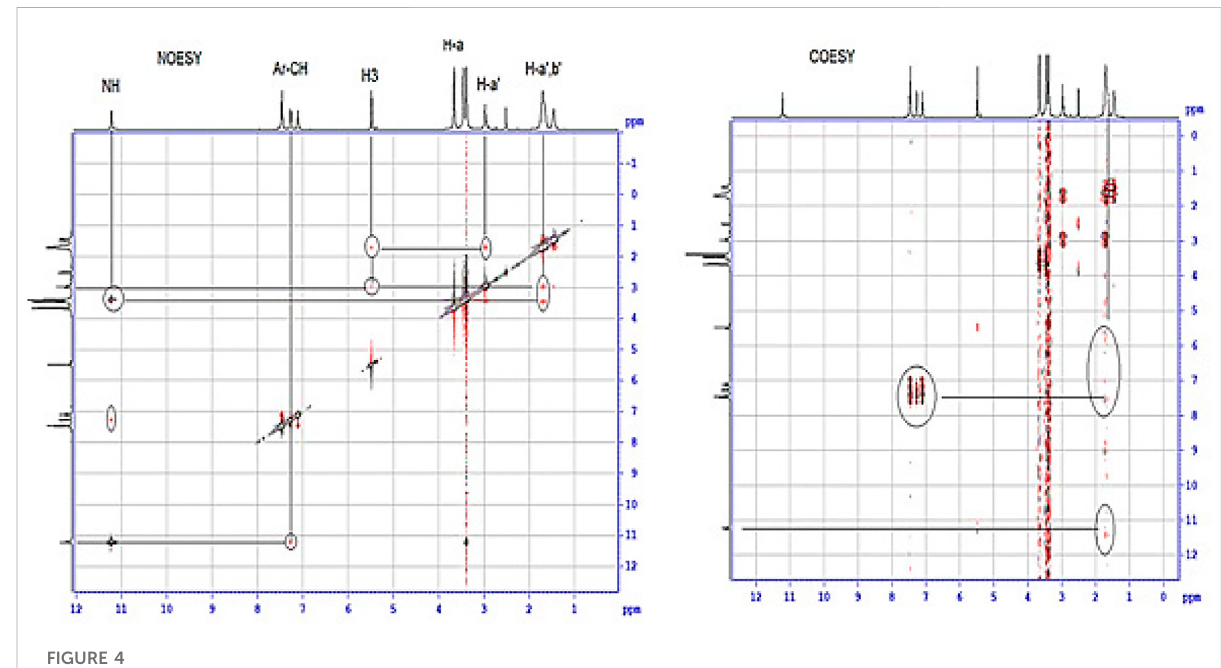
FIGURE 4 Part of NOSY and COSY spectrum for compound 4g